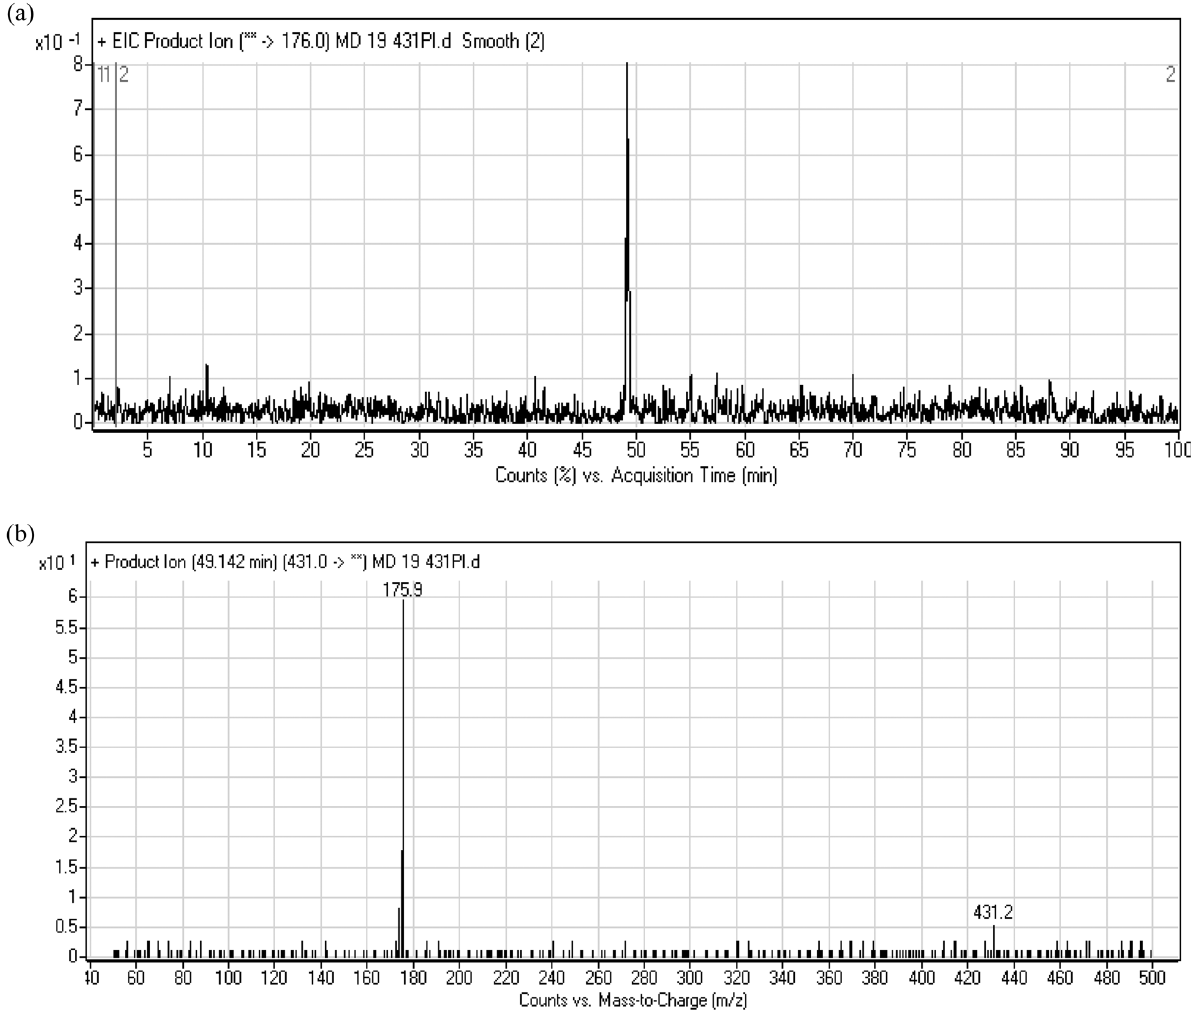
Figure 5: PI chromatogram of M1 showing a chromatographic peak at 49.1 min ( a ) and PI mass spectrum of M1 ( b ) . ( PI fragmentation of M1